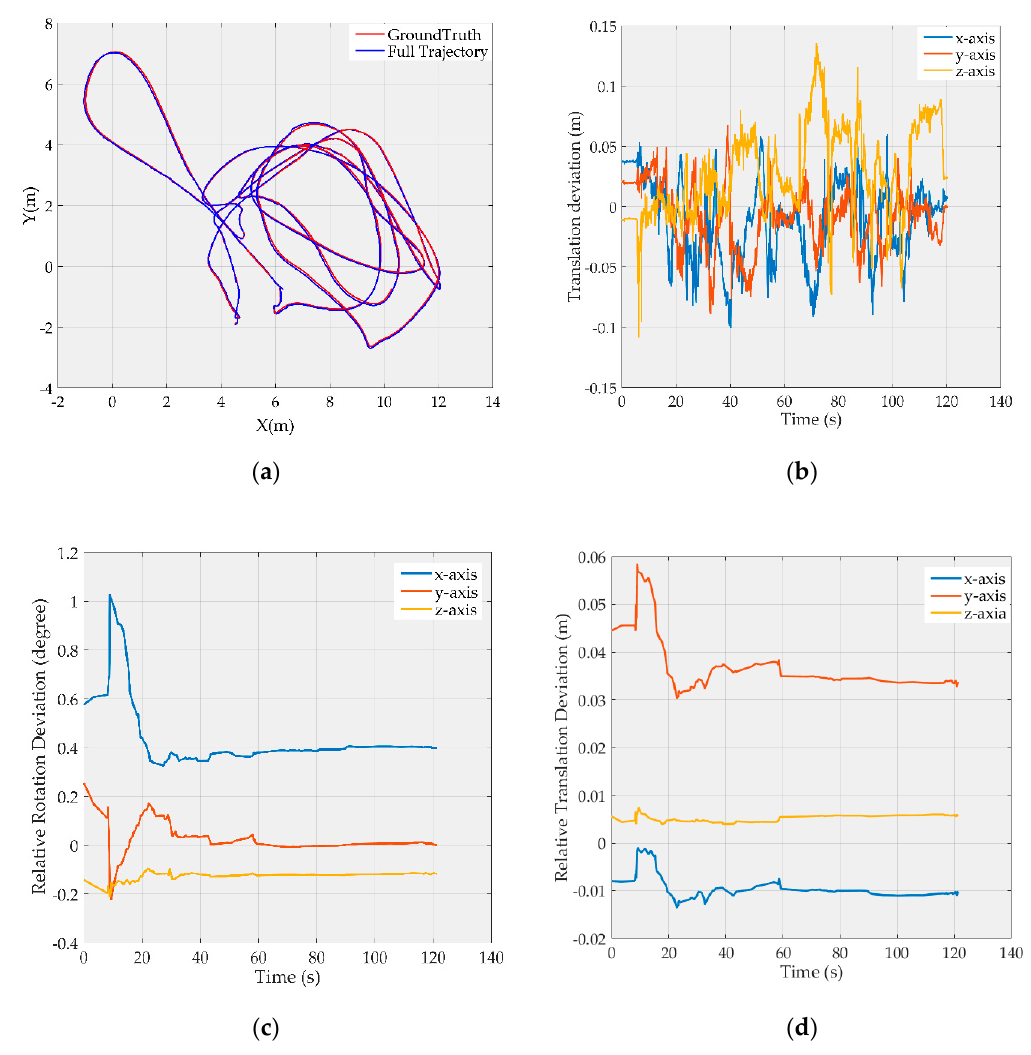
Figure 2. Results for the MH_03_medium image sequence after visual-inertial initialization: ( a ) Full trajectory after visual-inertial initialization; ( b ) Translation deviation with respect to the ground truth; ( c ) Rotation deviation of camera-to-IMU transformation; ( d ) Translation deviation of camera-to-IMU transformation.